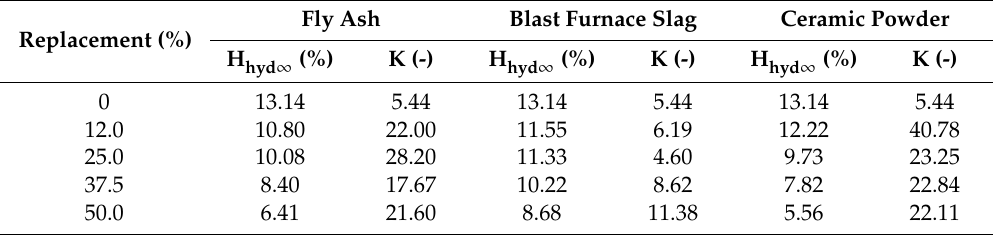
Table 4. Estimated ultimate content of chemically bounded water using Michealis-Menten equation. Replacement (%)